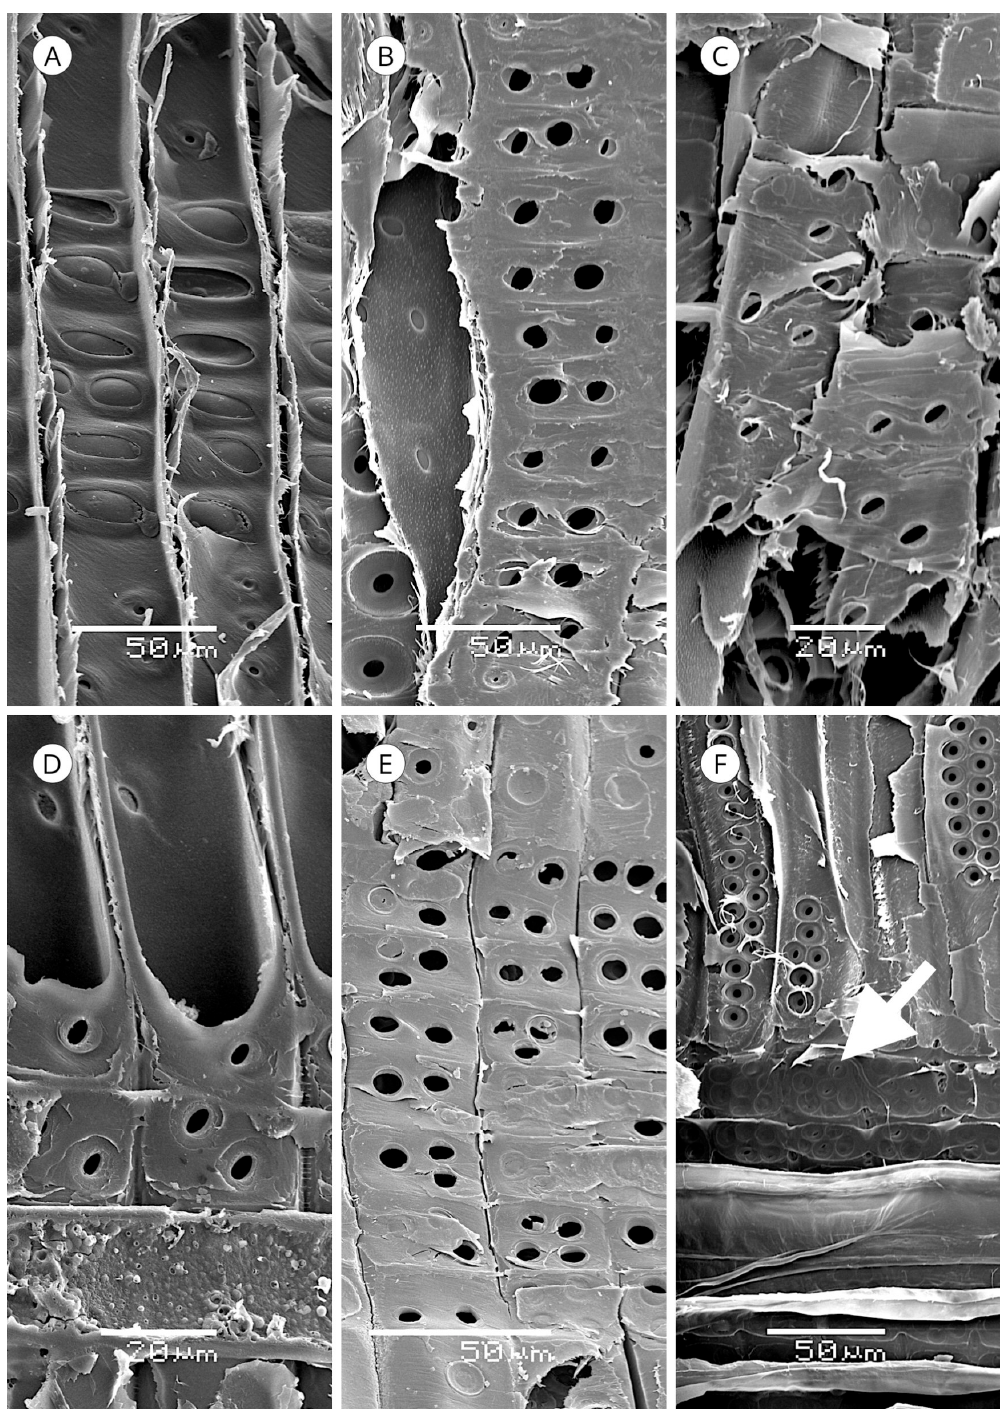
Figure 37. Cross-field pitting (SEM). ( A ) Window-like in Sciadopitys verticillata (Thunb.) Siebold and Zucc.; ( B ) Pinoid in Pinus pinea L.; ( C ) Piceoid in Cedrus atlantica (Endl.) Manetti ex Carrière; ( D ) Cupressoid in Juniperus chinensis L.; ( E ) Taxodioid in Glyptostrobus pensilis (Staunton ex D.Don) K.Koch; ( F ) Araucarioid in Araucaria cunninghamii Mudie.